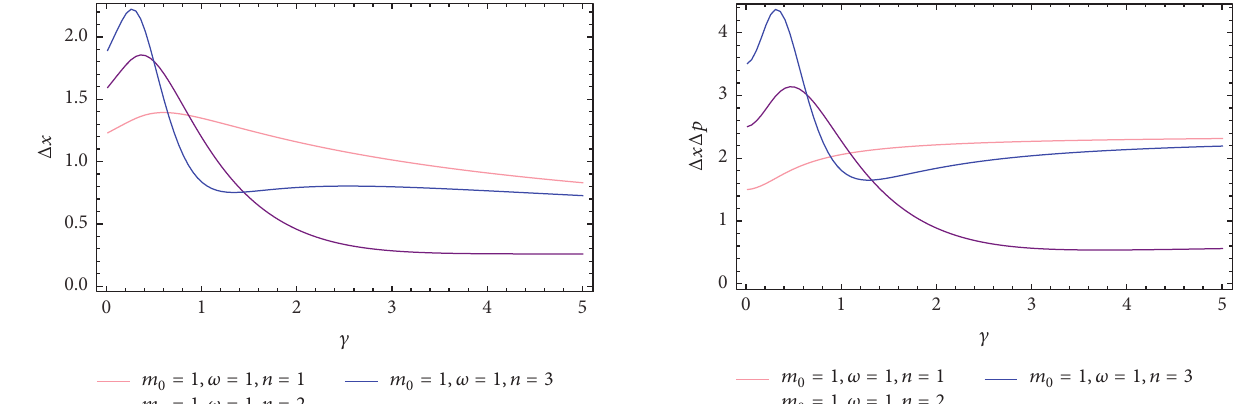
illustrate the physical characteristics and asymptotic behavior of the